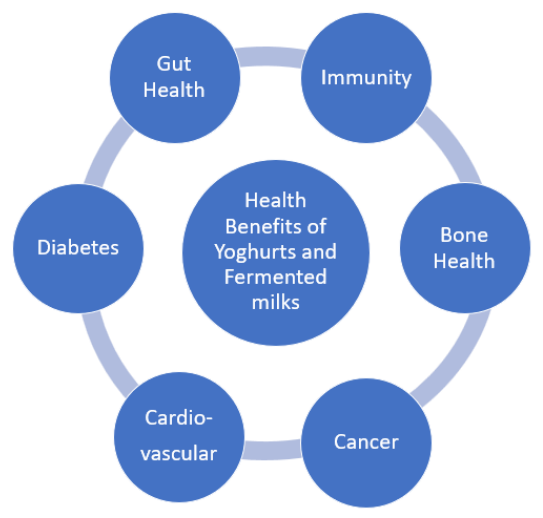
Figure 1. Health benefits of yoghurts and fermented milks.